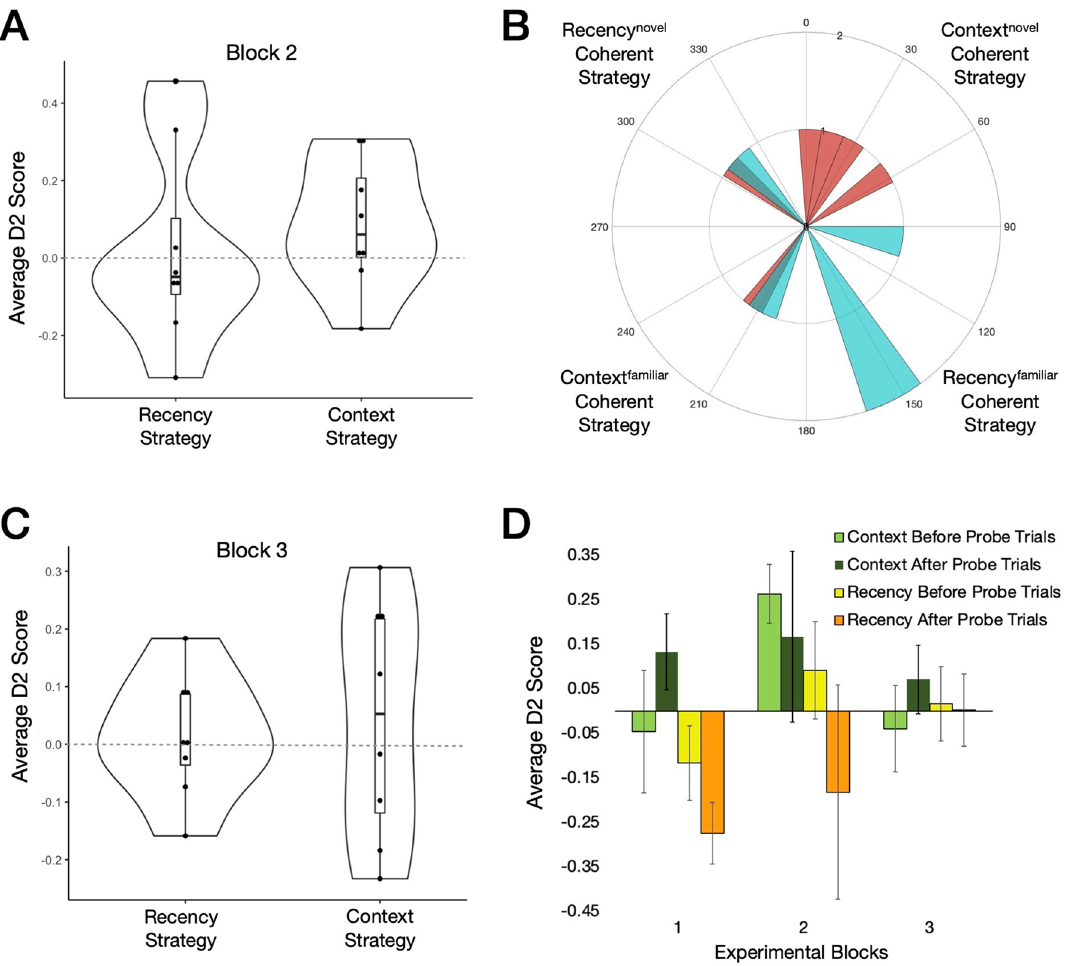
Figure 4. Experimental blocks 2 and 3 and performance across blocks. ( A ) Block 2 (probes excluded): The overall average context D2 score (M = 0.09, SD = 0.17) and the average recency D2 score (M = 0.02, SD = 0.25) did not differ from zero ( t (7) = 1.47, p = 0.18, d = 0.52; t (7) = 0.24, p = 0.82, d = 0.09; respectively). There was no side bias present (M = 0.09, SD = 0.24; t (7) = 1.01, p = 0.35, d = 0.36). ( B ) Angular histogram before probe angles (red), after probe angles (blue) for block 2; 20 bins of 18°. Both the before probe trial (M = − 0.2°, SD = 64.8°, n = 6) and the after probe trial angles (M = 159.0°, SD = 74.7°, n = 5) were uniformly distributed around the circle (Rayleigh test: Z = 1.67, p = 0.19; Z = 0.92, p = 0.42; respectively). ( C ) Block 3 (probes excluded): The average context D2 score (M = 0.04, SD = 0.20) did not differ from zero ( t (7) = 0.59, p = 0.57, d = 0.21), nor did the recency D2 score (M = 0.01, SD = 0.11; t (7) = 0.38, p = 0.72, d = 0.13). Additionally, there was no side bias (M = 0.03, SD = 0.12; t (7) = 0.60, p = 0.57, d = 0.21). ( D ) Average before probe context D2 scores, after probe context D2 scores, before probe recency D2 and after probe recency D2 scores across experimental blocks 1 to 3. Error bars denote ±